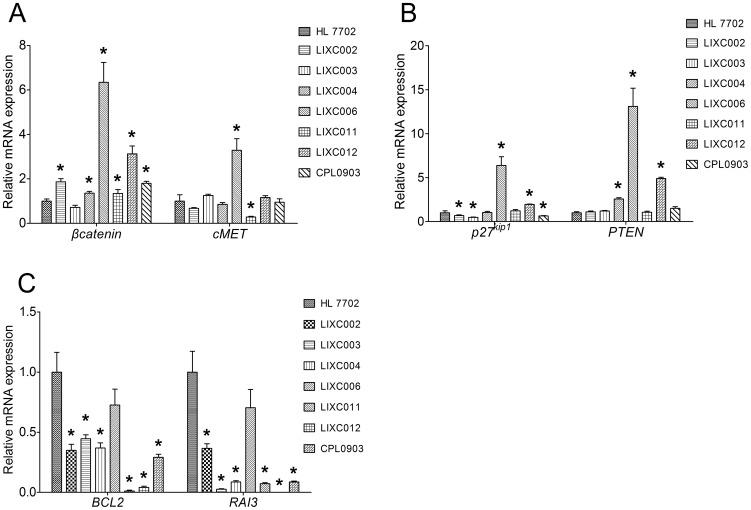
mRNA expression level of some tumor related genes in new cell lines.A, mRNA expression of βcatenin was up-regulated in all cell lines except LIXC003. LIXC006 cell expressed cMET mRNA significantly higher than HL 7702, while it was opposite in LIXC011. B, mRNA expression of p27kip1 was down-regulated in LIXC002, LIXC003 and CPL0903 cell lines, but up-regulated in LIXC006 and LIXC012 cell lines. LIXC004, LIXC006 and LIXC012 expressed significantly higher PTEN mRNA than HL 7702. C, BCL2 and RAI3 mRNA was down-regulated in all cell lines. Data are expressed as the fold expression relative to the control HL 7702 cell and represented the mean ± S.D. of three individual experiments. *, P<0.05 compared with HL 7702 cell.